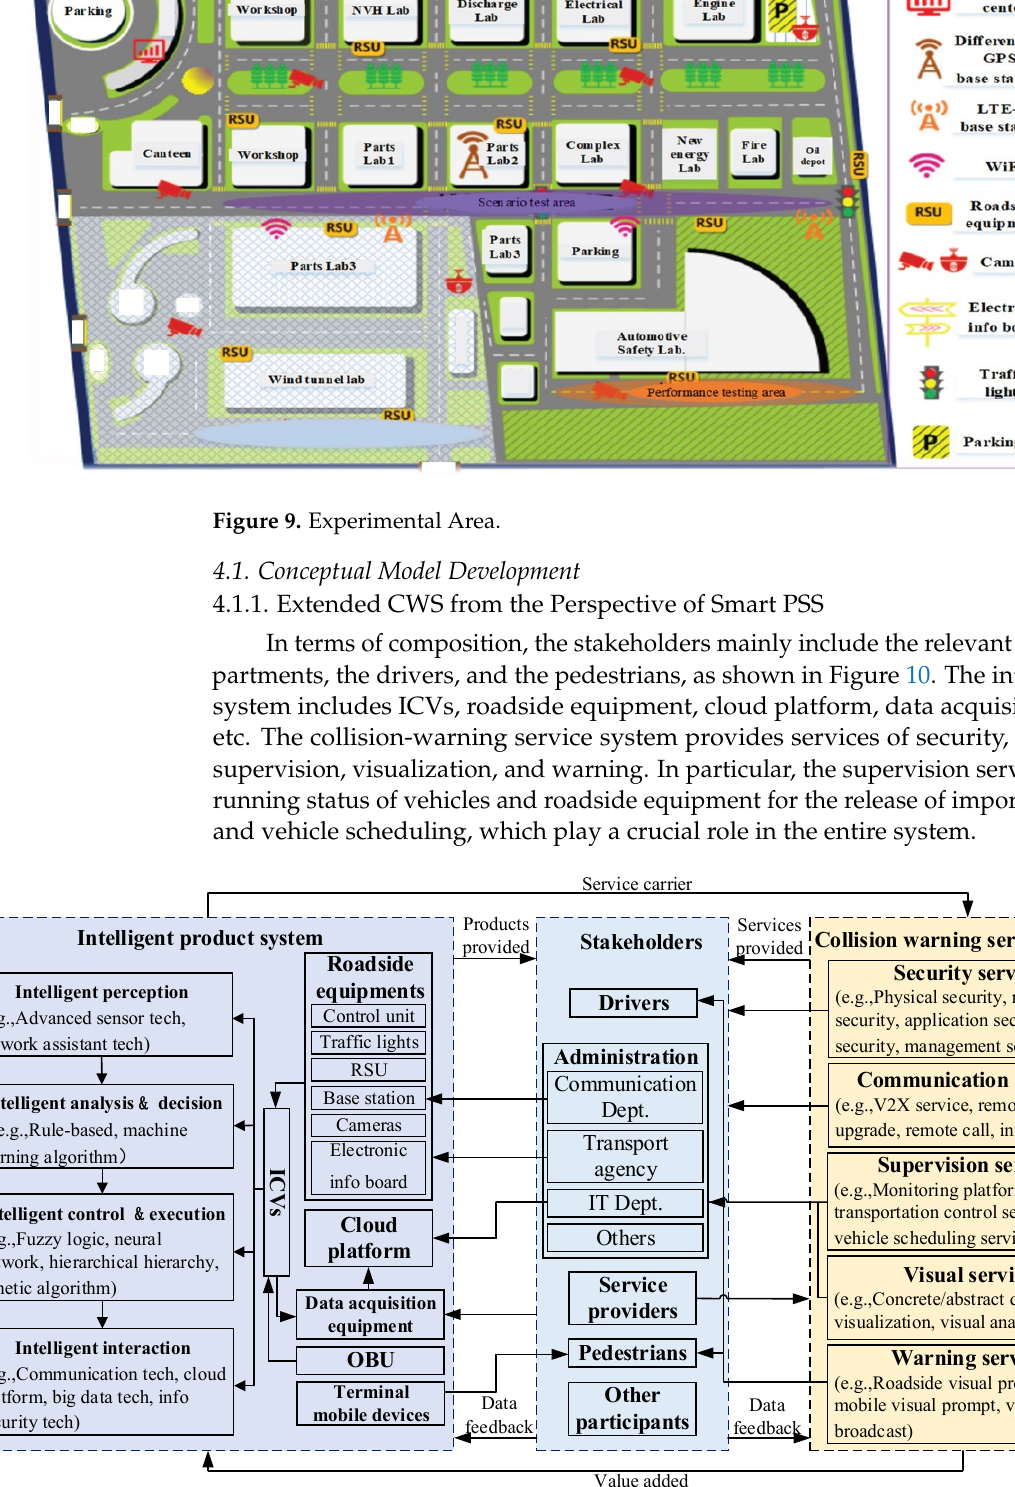
Figure 8. ( a ) Dongfeng S50 EV. ( b ) Sightseeing vehicle.